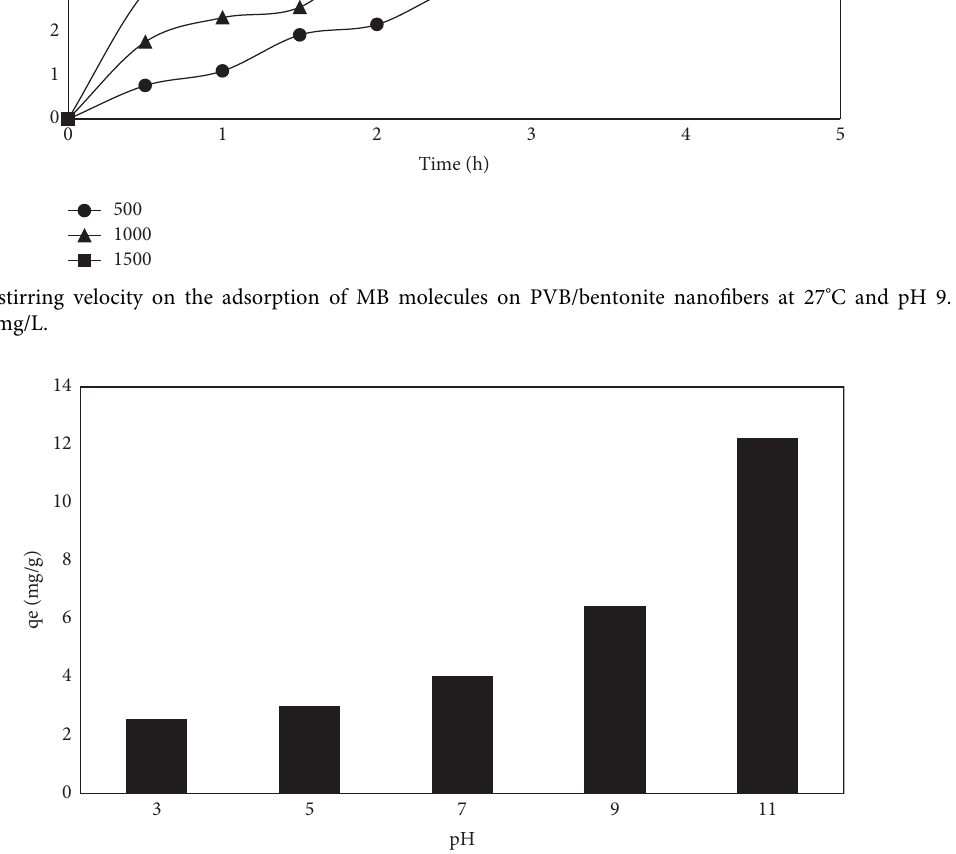
Figure 8: Efect of solution pH on MB molecules using PVB/bentonite nanofbers at 27 ° C and 500rpm. Initial dye concentration of